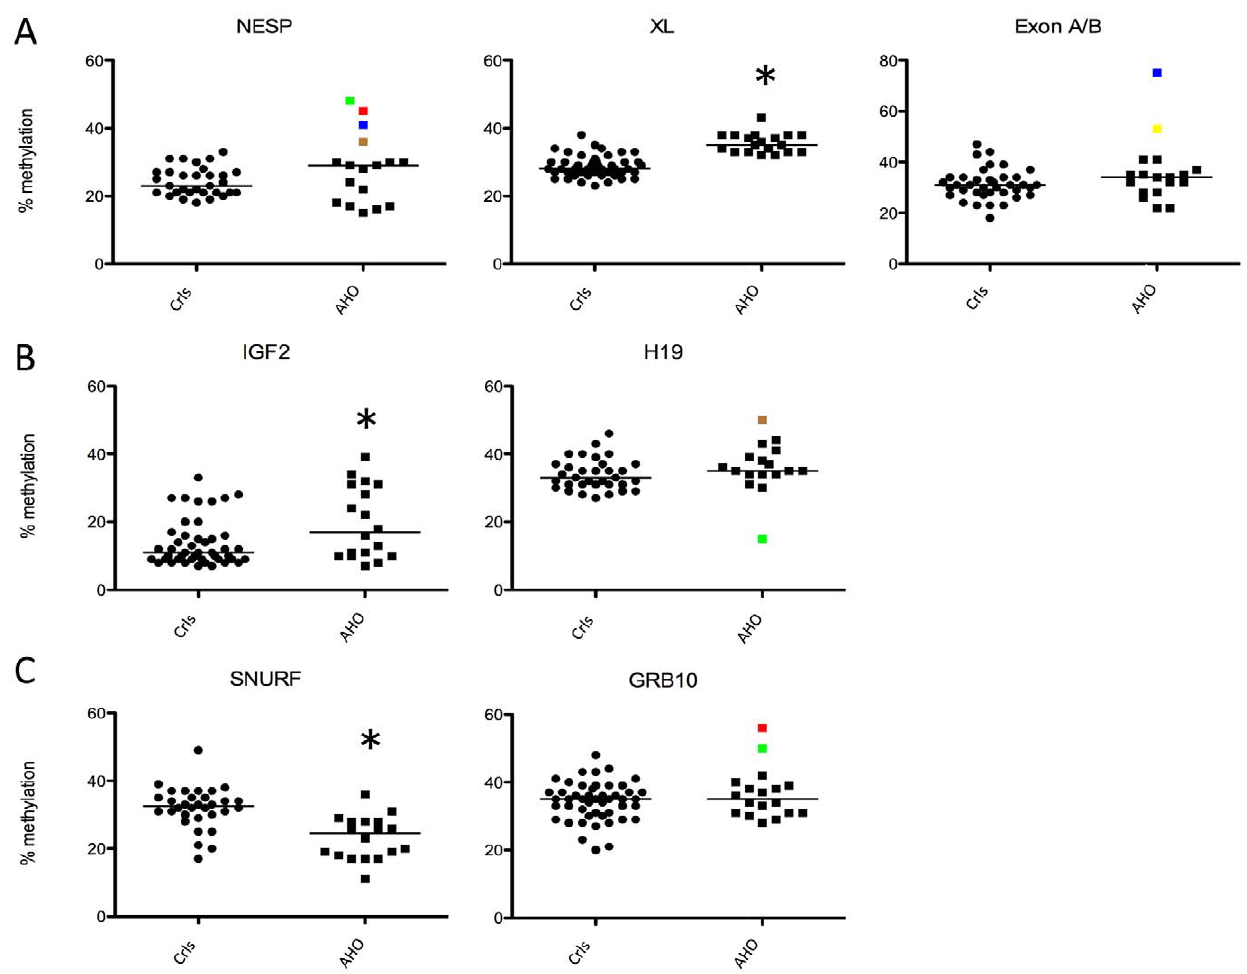
Figure 1. Overall GNAS , IGF2 , H19 , SNURF and GRB10 methylation in AHO-like patients. Dot plot representation of overall methylation values (averages expressed as % of methylation) for NESP, XL, Exon A/B (A), IGF2 , H19 (B), SNURF and GRB10 (C) in AHO-like patients (indicated as ‘PPHP’) vs. the control population (indicated as ‘crls’). Individuals with significant hyper- or hypomethylation (patients 1 to 5) in the NESP, Exon A/B, H19 and GRB10 are indicated as follow: patient 1= red, 2= green, 3= blue, 4= brown, 5= yellow. Medians are displayed as black lines. ** p , 0.01 and * p , 0.05, two-tailed unpaired T-test.